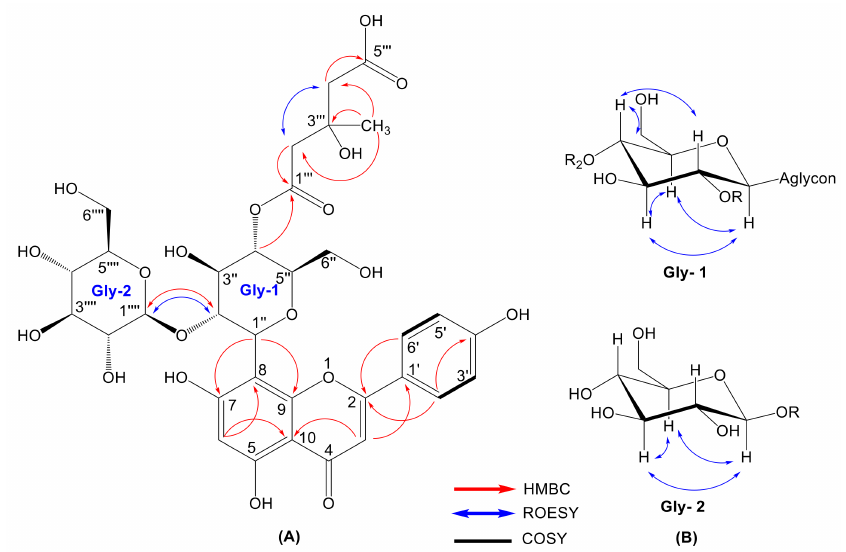
Figure 2. Details of NMR characteristics of compound 1 . ( A ) Full structure; ( B ) Detail of ROESY correlation of glucose